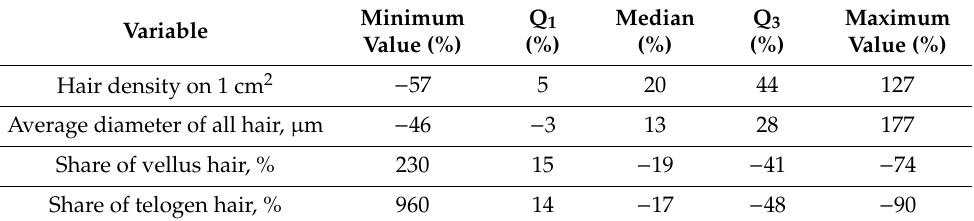
Table 5. Dynamics of hair growth indicators after treatment by quartiles of growth